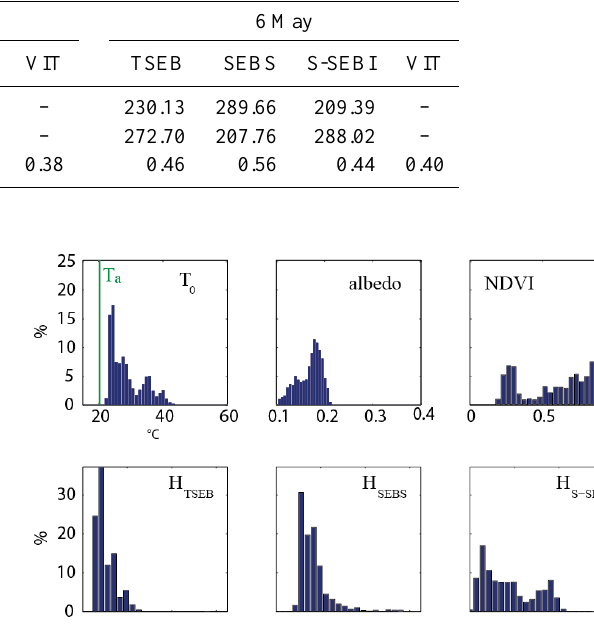
Table 4. Mean values of turbulent flux and water stress on the whole area at two dates of ASTER overpass.